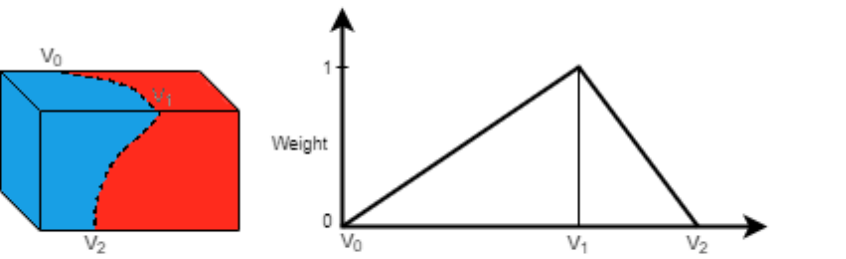
Figure 19. Color adjustment method. The left image illustrates a mesh. The right image represents the variation in sample weight in relation to the distance to v 1 . Adapted from [126].